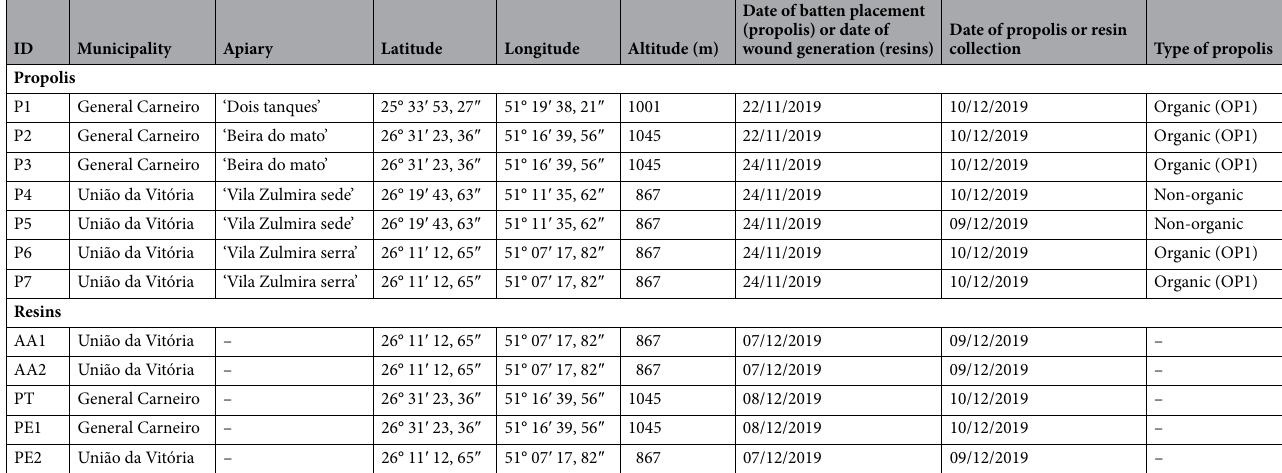
Table 1. Propolis and resin samples from permanent preservation areas and reforestation areas of southern Brazil. OP1 organic propolis variant 1 4